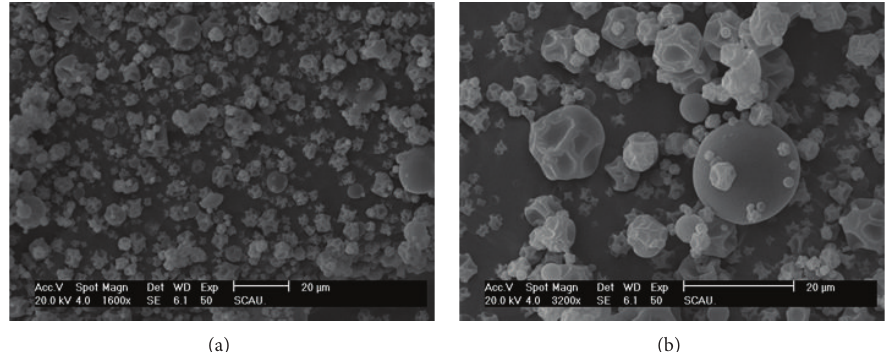
Figure 2: Scanning electron micrographs of FEMs prepared at optimal condition (a) 1600x magnification; (b) 3200x magnification.